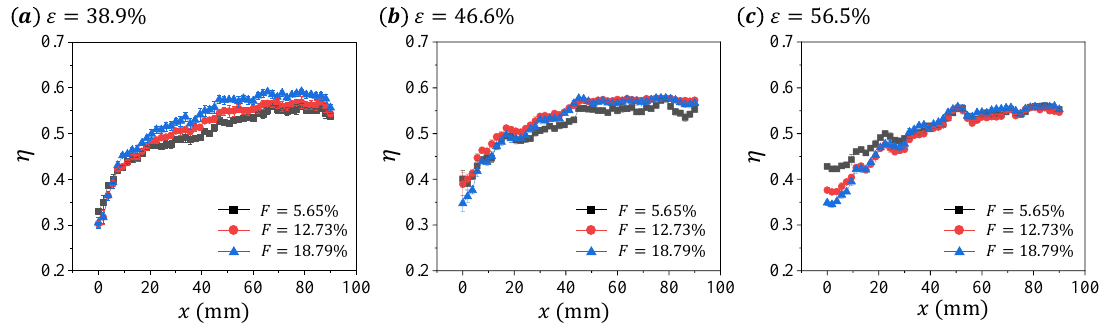
Figure 6. The distribution of cooling efficiency η on the central line of the test sample for different blowing ratio F at same porosity ε : ( a ) ε = 38.9%, ( b ) ε = 46.6%, and ( c ) ε =